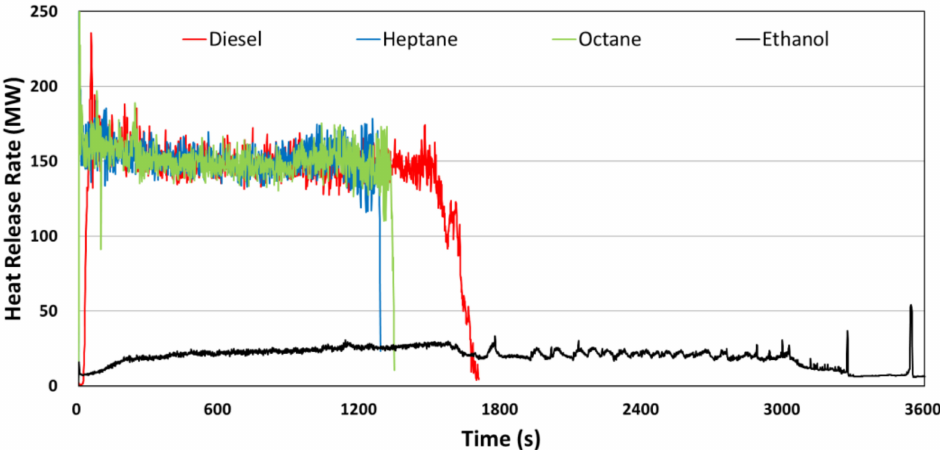
Figure 2. Heat release rates of the tested combustion